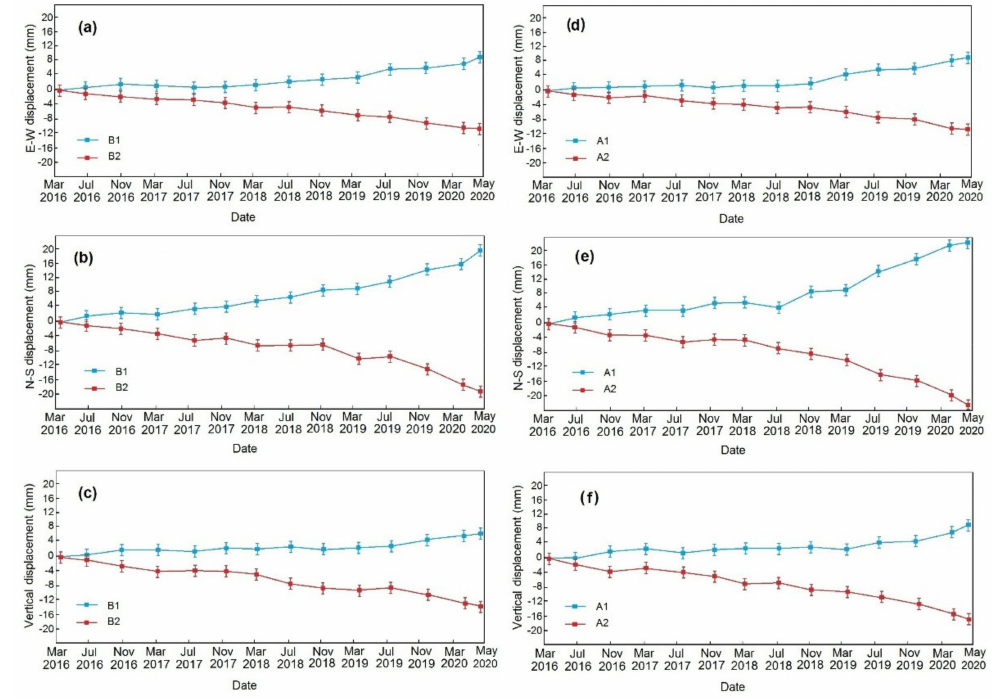
Figure 7. Time series graph of the displacement of fault blocks at points A1, A2 and B1, B2; the position of points A1, A2 and B1, B2 (see Figure 6). ( a , d ) E–W displacement, ( b , e ) N–S displacement, ( c , f ) vertical displacement.